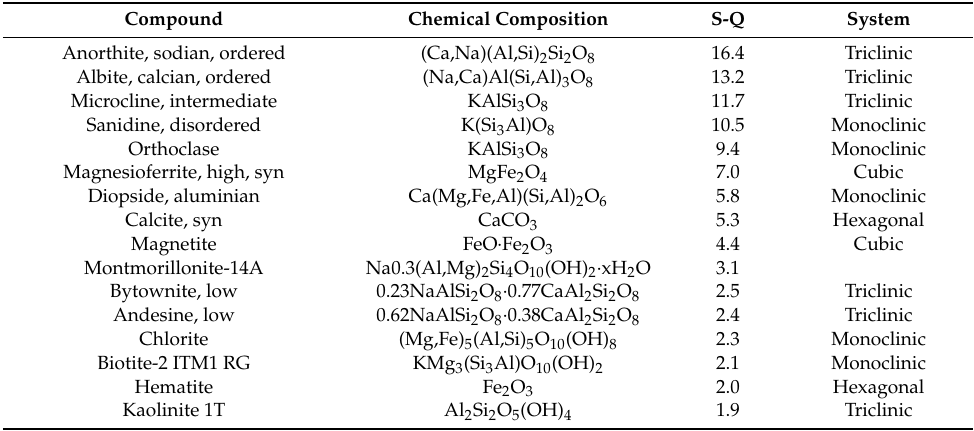
Table 2. The X-ray di ff raction (XRD) analysis results obtained from Abbas Abad copper ore sample